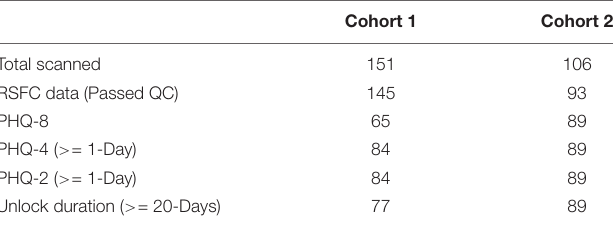
TABLE 1 | Summary of the number of subjects in each